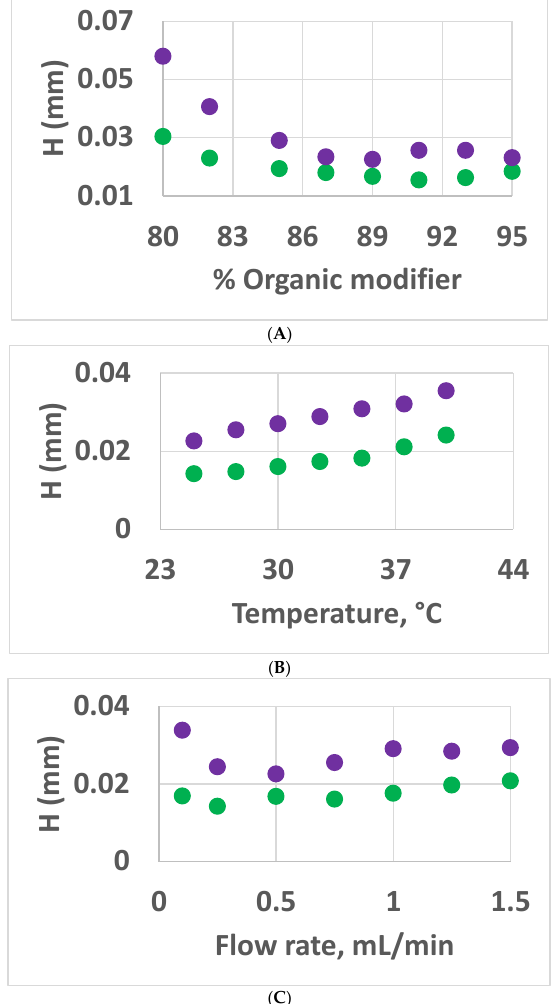
Figure 6. Height equivalent of theoretical plates compared to the composition ( A ), temperature ( B ), and flow rate ( C ). Composition for B and C was 89% organic modifier, temperature for A and C was 25 °C, and flow rate for A and B was 0.5 mL/min. Top profile (purple): acetonitrile; bottom profile (green): dimethyl carbonate. Error bars (standard deviation) within the points. Average % RSD for points (n = 3): Composition A) MeCN: 2.9%, DMC: 6.4%; temperature B) MeCN: 4.2%, DMC: 4.7%; flow rate C) MeCN: 8.9%, DMC: 8.8%.